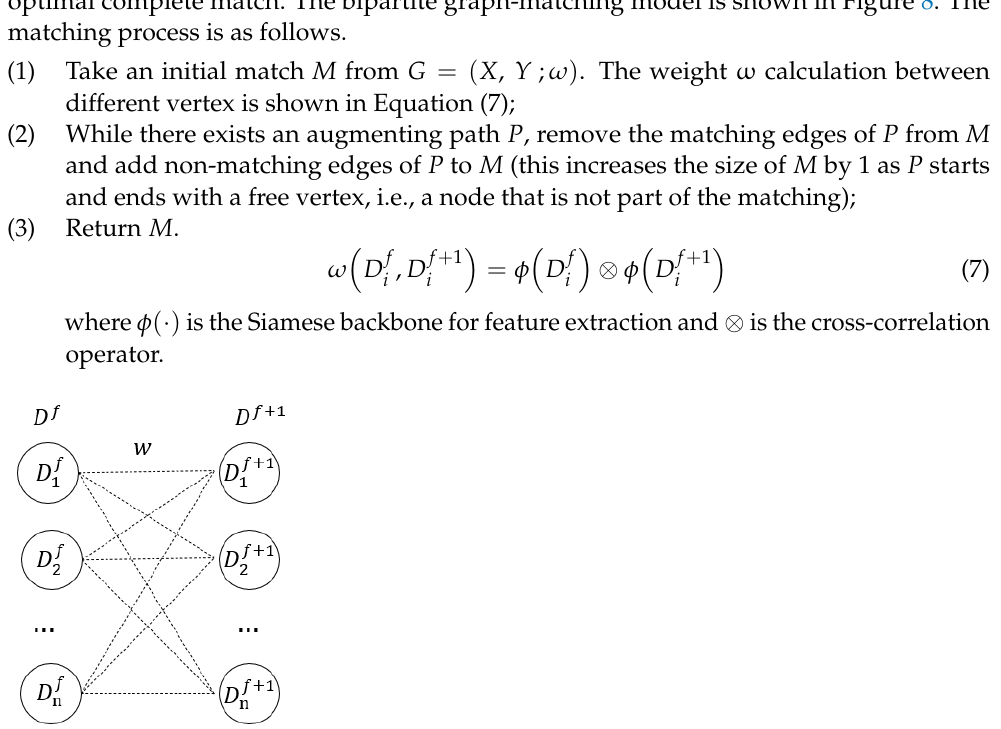
( c ) Figure 7. Dynamic template set update. ( a ) shows the original template of the tracking process; ( b ) shows the scene where the appearance of the target has changed; ( c ) shows the updated template. 2.3.2. Assignment Algorithm Since there are lots of candidate objects, the corrector utilizes the Hopcroft–Karp al ‐